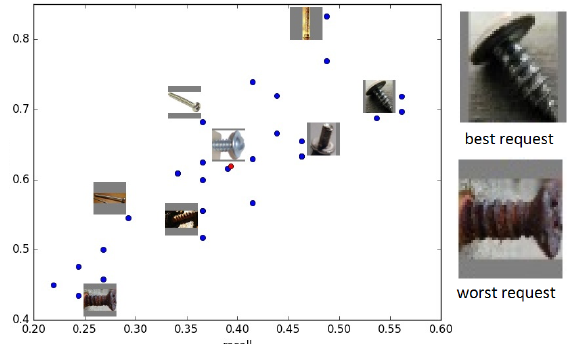
Figure 6. Precision and recall (for fixed threshold) for different